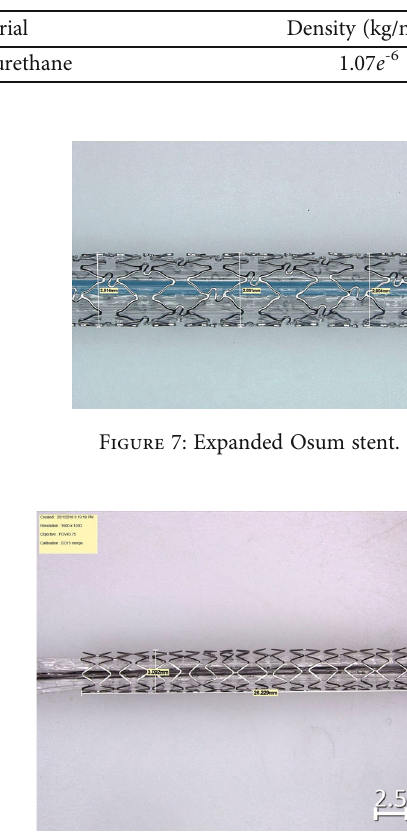
Figure 8: Envision 3 : 5 × 28 stent after expansion.